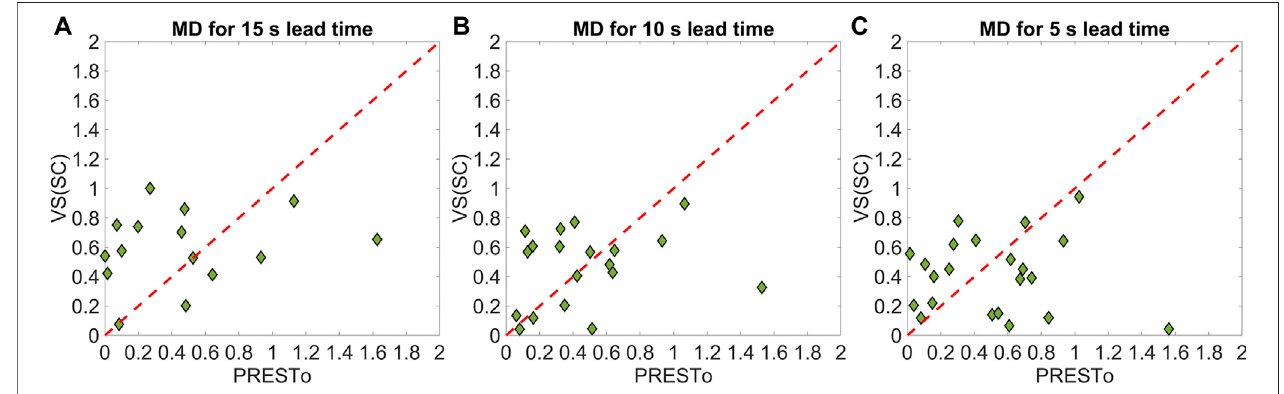
FIGURE8| Comparingtheground-shakingpredictionaccuracyofbothconsideredalgorithmsforthreeleadtimes: (A) 15 s, (B) 10 s,and (C) 5 s.TheaverageMD ( MD ) estimate is: (A) MD (cid:2) 0 . 45 for PRESTo and MD (cid:2) 0 . 86 for VS(SC), (B) MD (cid:2) 0 . 47 for PRESTo and MD (cid:2) 0 . 47 for VS(SC), (C) MD (cid:2) 0 . 82 for PRESTo and MD (cid:2) 0 . 42 for